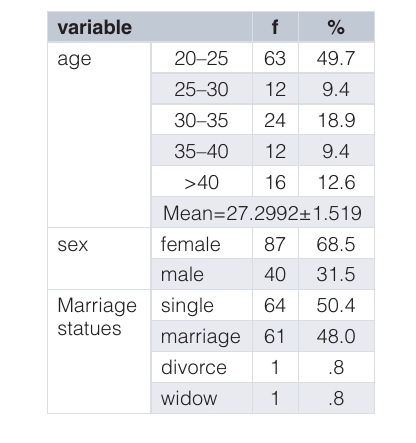
Table 1. Frequency distribution of participant characteristics.